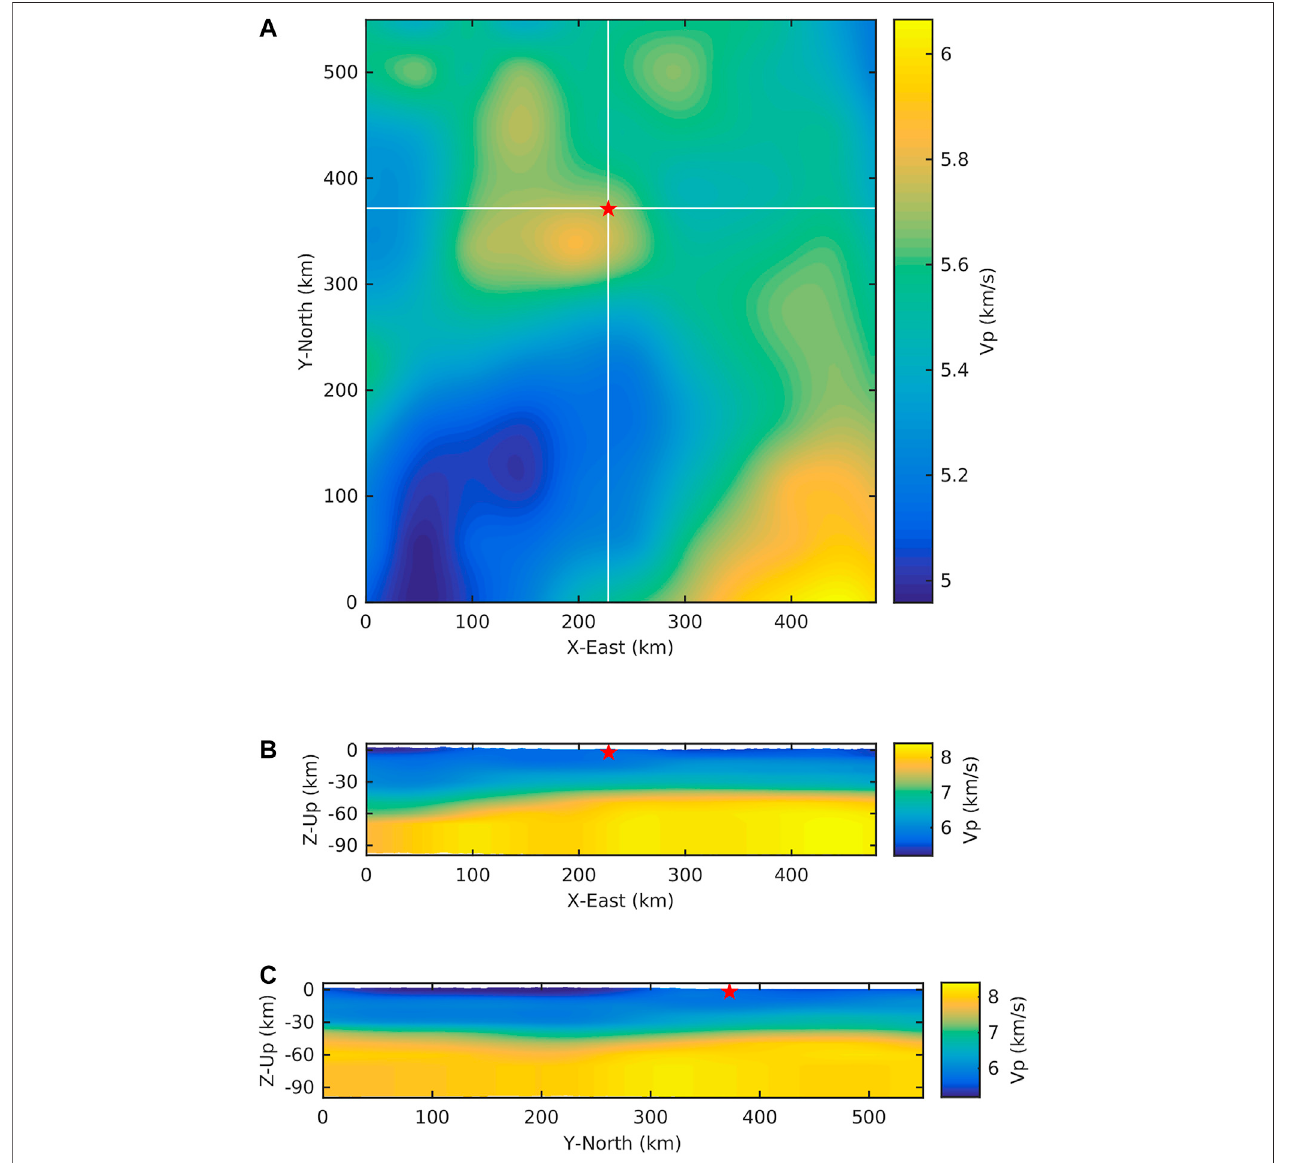
FIGURE 3 | The map view and two pro fi les of the 3D P-wave velocity model across the event location (red star). The horizontal and vertical white lines in map view (A) show the location of XOZ pro fi le (B) and YOZ pro fi le (C) respectively.